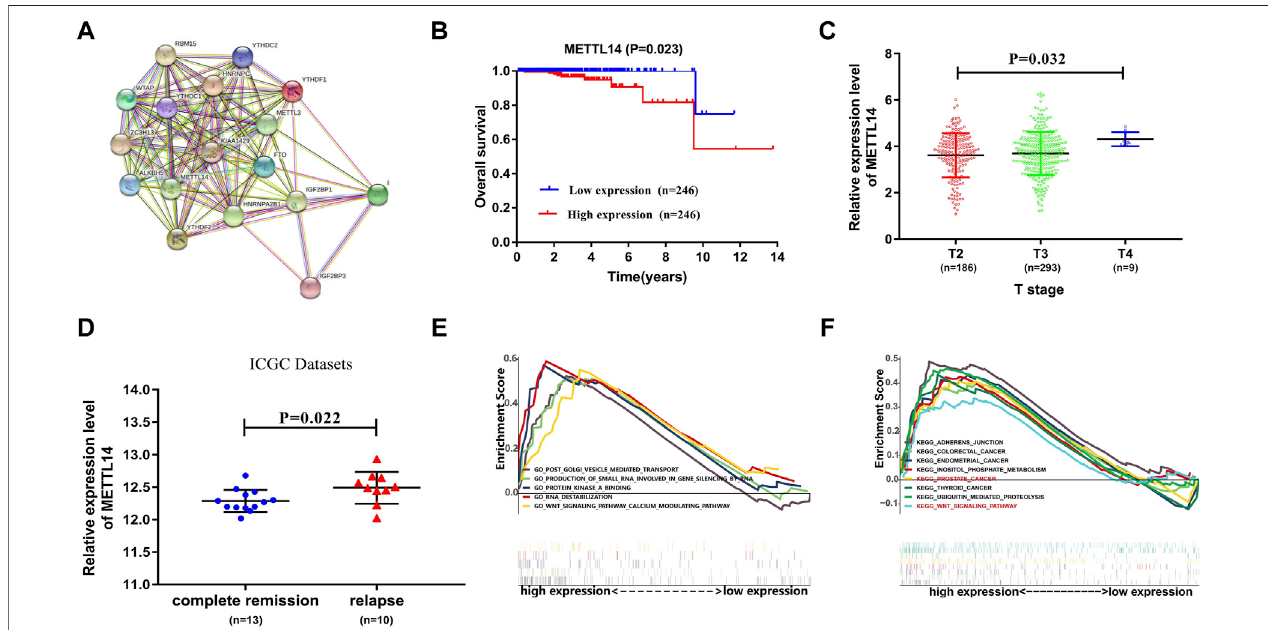
FIGURE 5 | Underlying prognostic value of METTL14 in PCa. (A) Protein – protein interaction network of 17 m 6 A regulators in which the key role of METTL14 is shown. (B) Kaplan – Meier analysis of METTL14 with low expression (blue) and high expression (red) in PCa patients. (C,D) The association of METTL14 expression with different tumor stages and disease status. (E,F) . Gene set enrichment analysis for TCGA PCa samples with high expression of the METTL14 signature.